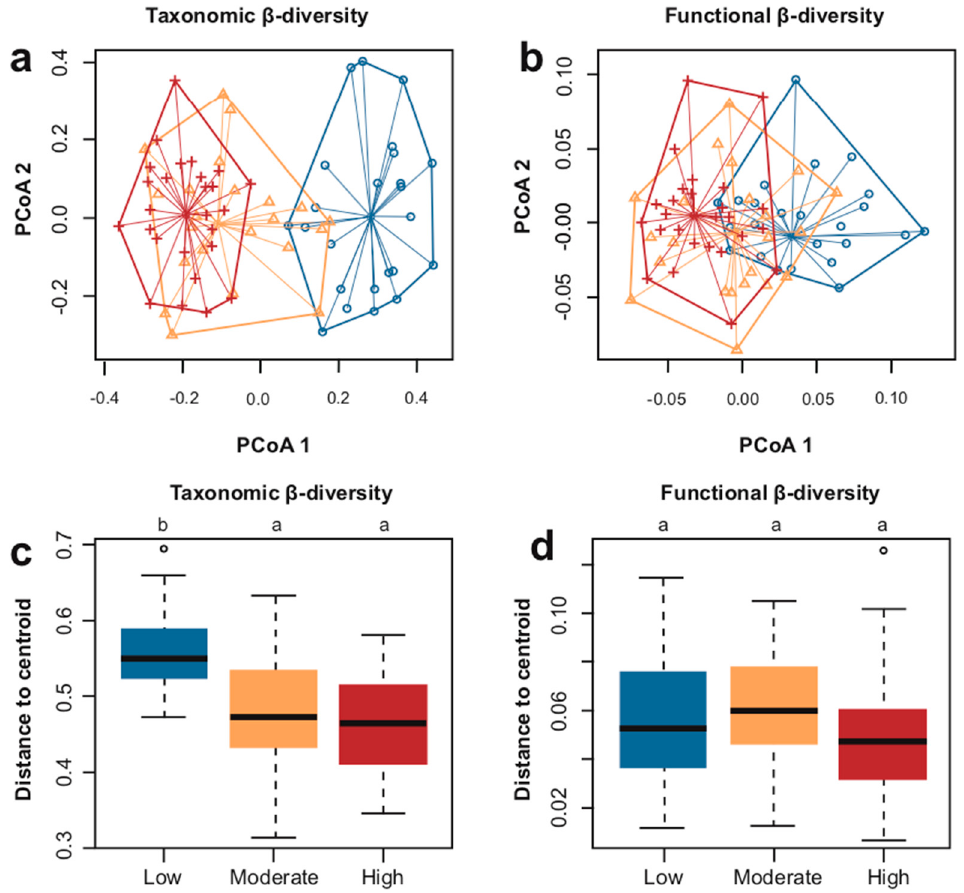
Figure 4. Effect of different degradation levels on the multivariate dispersion of species ( a , c ) and trait ( b , d ) composition in floodplain landscape. Taxonomic and functional β -diversity is measured as the distance of sites to their group centroid (using Bray–Curtis and Gower distances, respectively), here represented on the first two axes of a PCoA and using a boxplot (median and quartiles) of the sites-to-centroid distance. On the PCoA, a change in site dispersion around the centroid represents a change in β -diversity, while a change in the centroid location represents a species/trait turnover. Symbols represent each plot in different degradation levels: + = high, ∆ = moderate, and ○ = low. Values share same letter are not significantly different at 0.05 significance level. Table 4. Differences in β -diversity and composition in the floodplain landscape, according to three groups of degradation levels. Note: difference in β -diversity was tested with ANOVA by permutations on site–centroids distances and difference in location of centroid was tested with PERMANOVA.